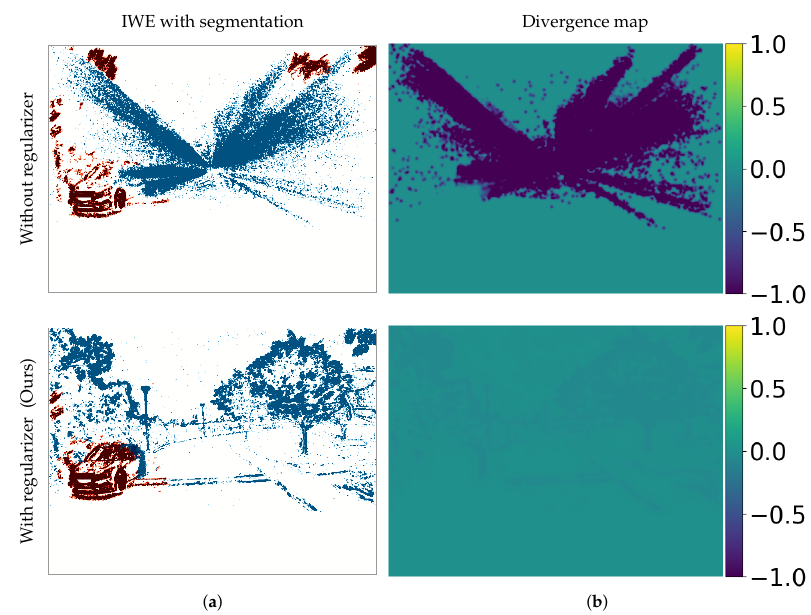
Figure 8. Application to Motion Segmentation . ( a ) Output IWE, whose colors (red and blue) represent different clusters of events (segmented according to motion). ( b ) Divergence map. The range of divergence values is larger in the presence of event collapse than in its absence. Our regularizer (divergence in this example) mitigates the event collapse for this complex motion, even with an independently moving object (IMO) in the